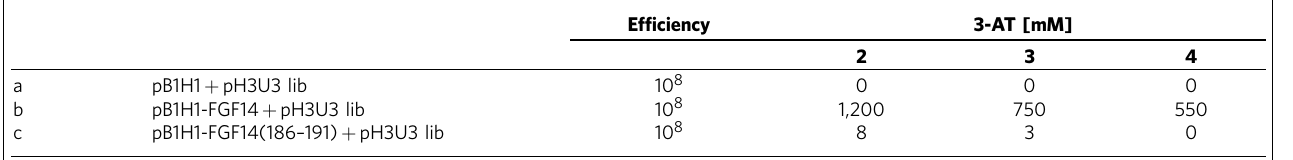
Table 2 | Number of surviving colonies on selective 3-AT plates using B1H assay.